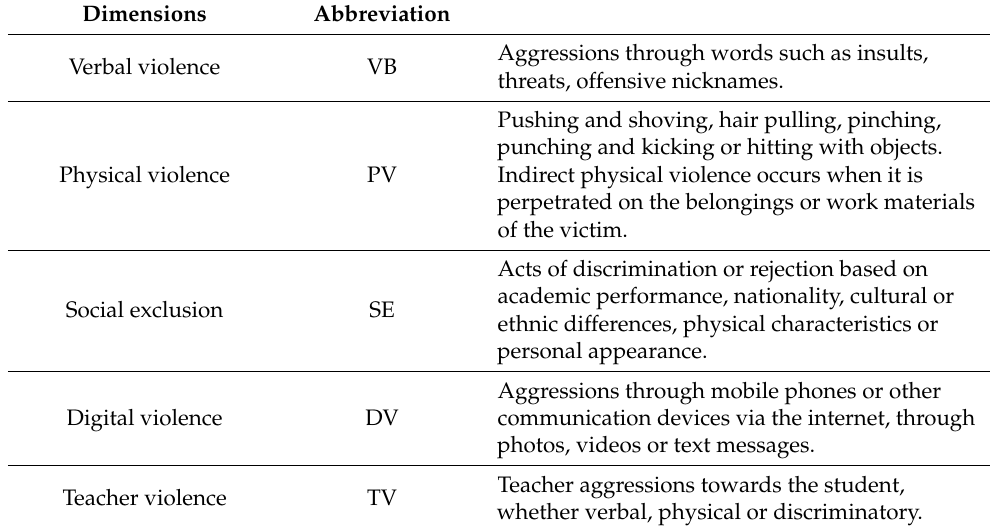
Table 5. Actions related to the dimensions of factor 1. Source: Muñoz et al. [4].